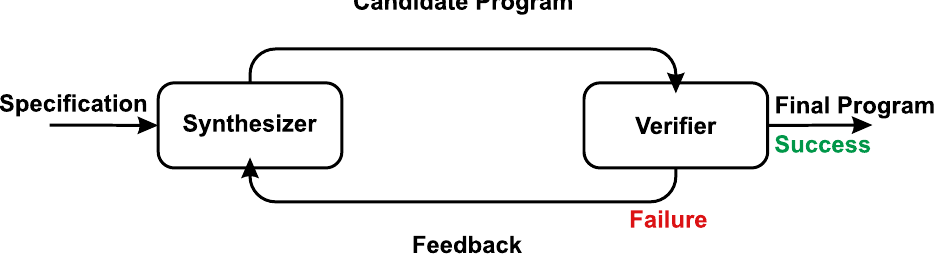
Figure 3. We illustrate the traditional CEGIS’ block diagram 9 , where the synthesizer provides candidate solutions, while the verifier checks whether these solutions meet the specification. We implement a learning algorithm in the synthesizer, responsible for refining candidate solutions based on feedback (counterexamples) provided by the